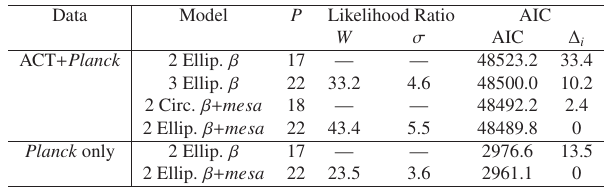
Table 1. The statistical information we used to compare the fitted